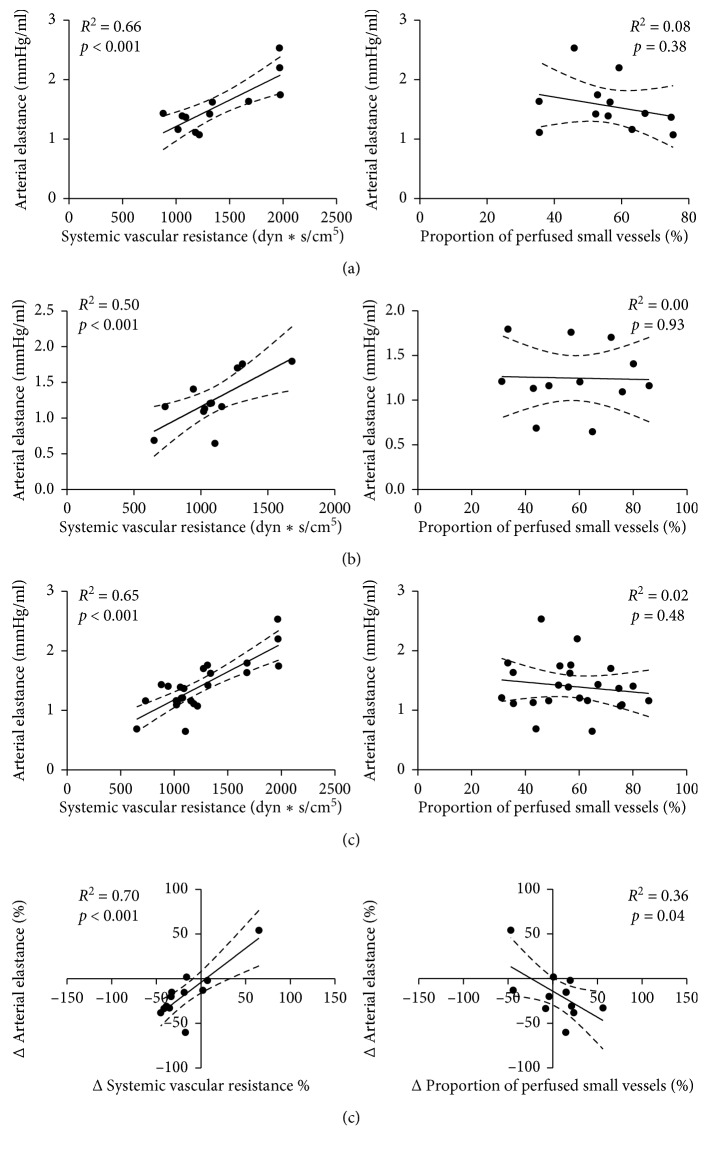
Correlation between arterial elastance and systemic vascular resistance (left column) and between arterial elastance and proportion of perfused small vessels (right column) in responders. (a) Baseline (T0); (b) after fluid challenge (T1); (c) all data (baseline plus after fluid challenge); (d) percentage of change between baseline and after fluid challenge.